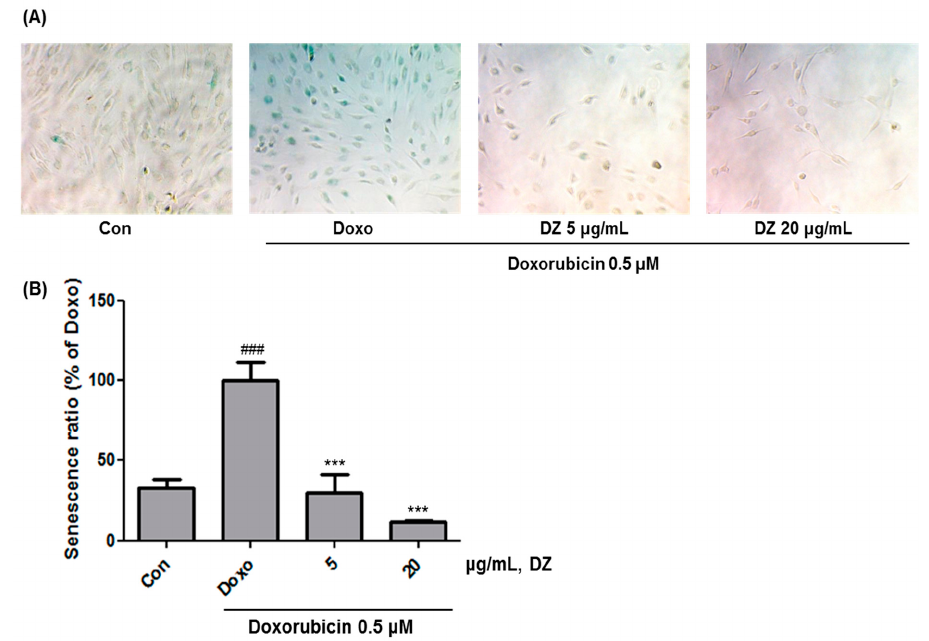
Figure 2. Suppression of doxorubicin-induced cellular senescence in HDFs by Dendranthema zawadskii (DZ) extract. Cellular senescence was assessed by SA- β -gal activity staining. HDFs were treated with 0.5 µ M doxorubicin for 4 h. After 24 h incubation, cells were treated with 5, 20 µ g/mL DZ extract and incubated for 3 days. Then, cellular senescence was measured. ( A ) SA- β -gal activity staining ( × 100). ( B ) Cellular senescence ratio. Percentages of staining cells. Values are the means ± SEs from three independent experiments measured in triplicate. Con, control; Doxo, cells were treated with 0.5 µ M doxorubicin for 4 h. Statistical significance: ### < 0.001 compared to Con. *** < 0.001 compared to Doxo, respectively.